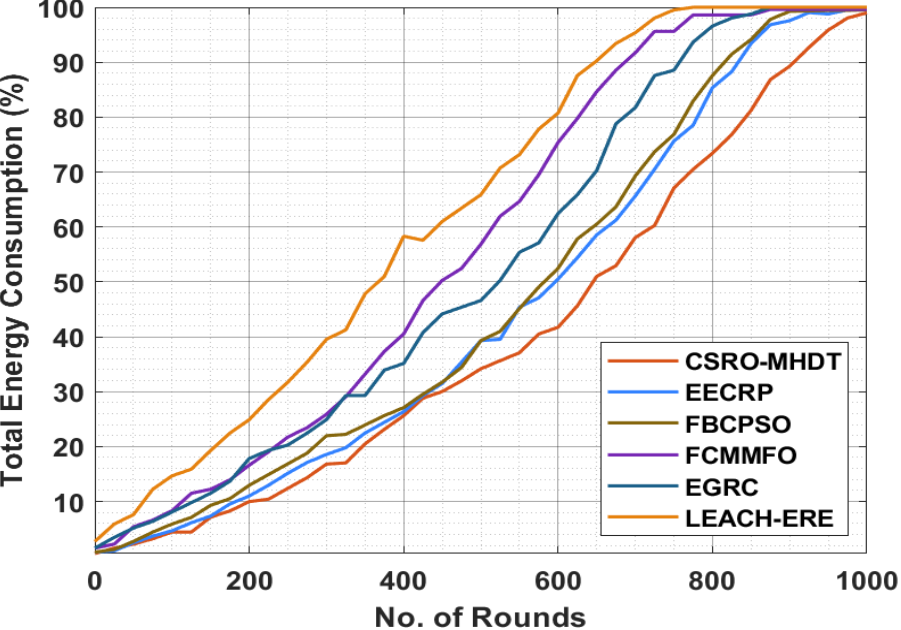
Figure 5. TEC analysis of the CSRO-MHDT method in comparison with current tactics. Table 5. PLR analysis of the CSRO-MHDT technique in comparison with existing approaches. Packet Loss Ratio